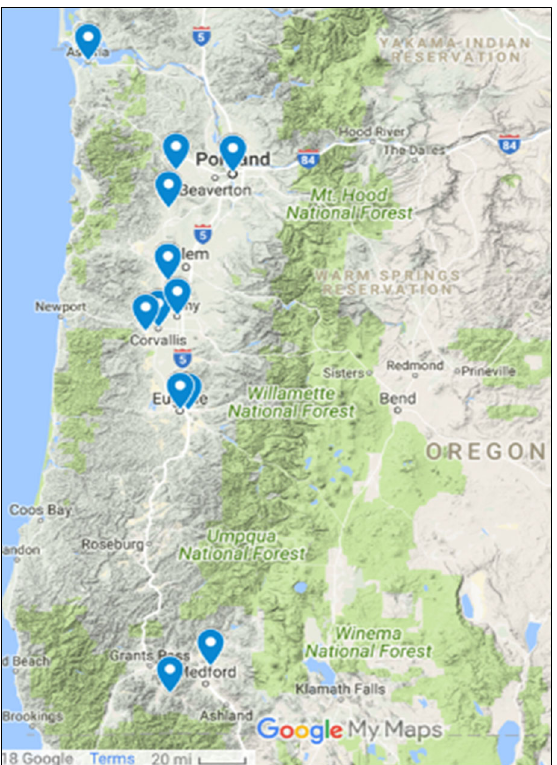
Figure 1. Map of Interview